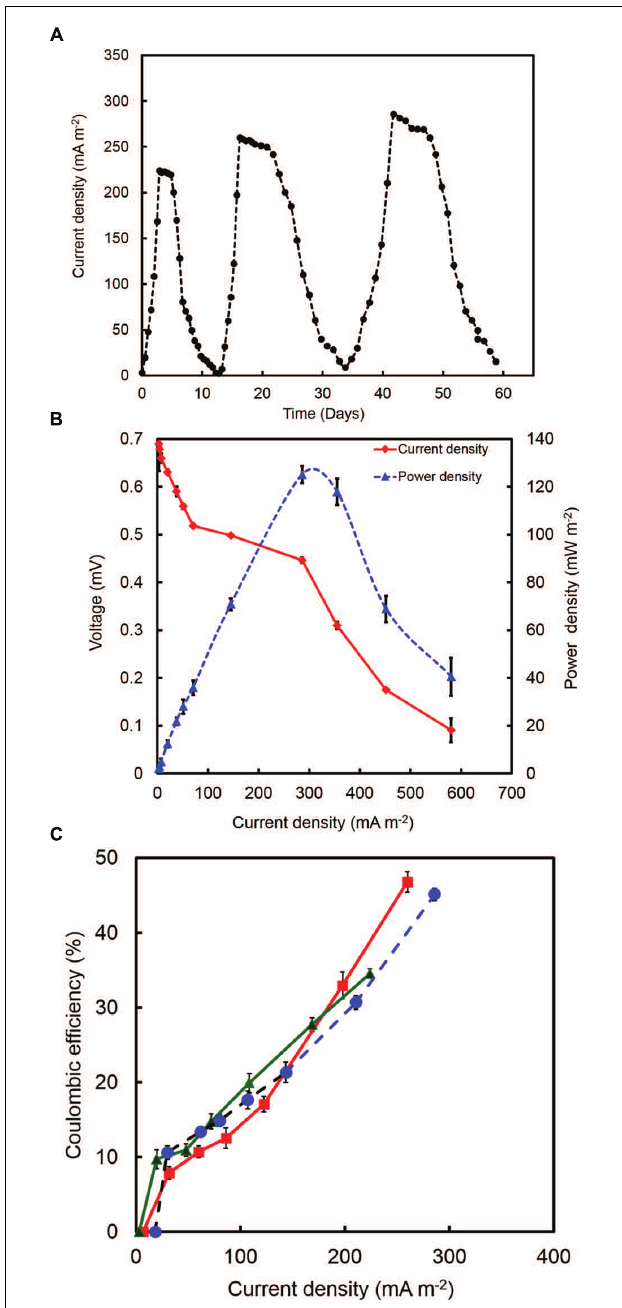
FIGURE 3 | (A) A few representative initial cycles of current density (average from triplicates) generated by strain RP2 fed with acetate. (B) Power density and voltage generation as a function of current density from strain RP2 inoculated acetate-fed bottle MFCs. (C) Coulombic efficiency (CE) of a few representative batches of acetate-fed bottle